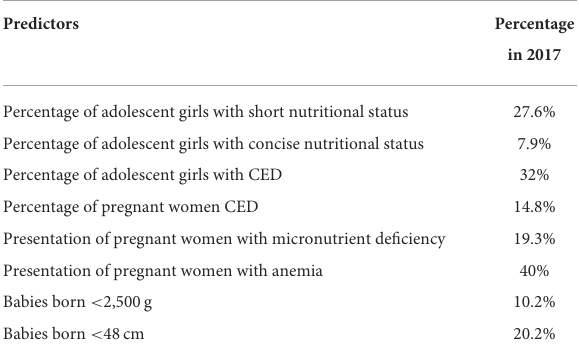
TABLE 1 Data on conditions that potentially as predictors of neonatal stunting in Indonesia (28).